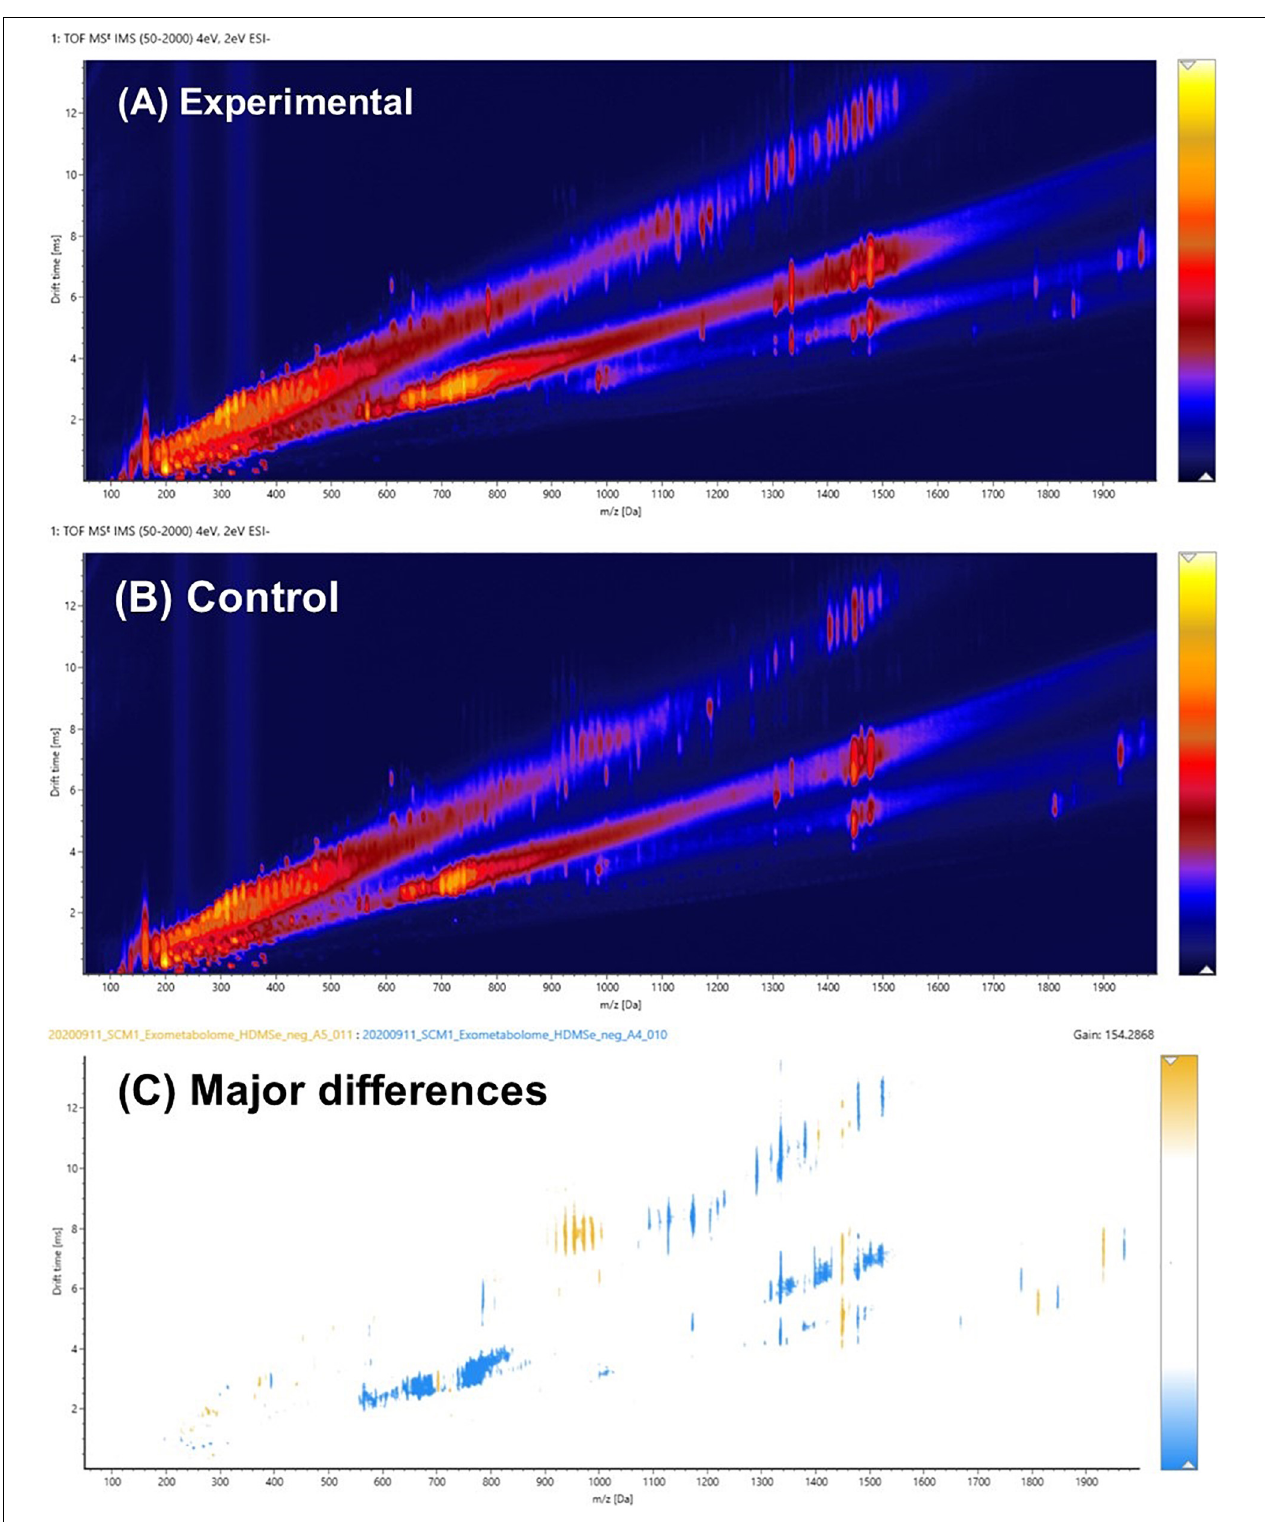
FIGURE 3 | (A) Pairwise comparison analysis of the ion mobility conformational spaces of an experimental culture medium and (B) a cell-free control medium after PPL-SPE extraction. The major differences between the pair are shown in (C) , in which light blue indicates the regions where biomolecules were produced and exported extracellularly to the culture medium, whereas yellow denotes the organics that might have been consumed or degraded over the course of the experiment. Data were acquired in the negative ion mode.